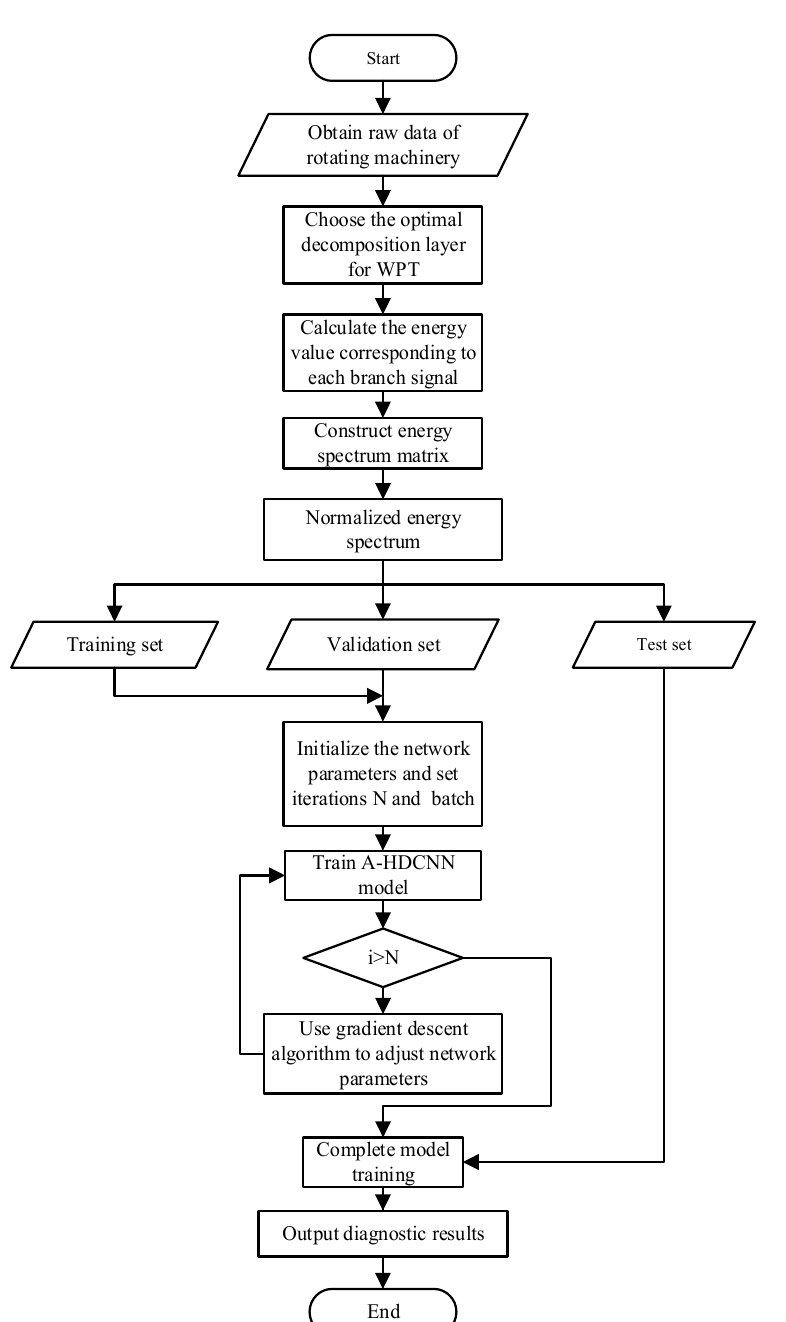
Figure 4. A-HDCNN sub-model training process. The fault damage size of each sample is a mapping of its model predicted probability value, which can be calculated as